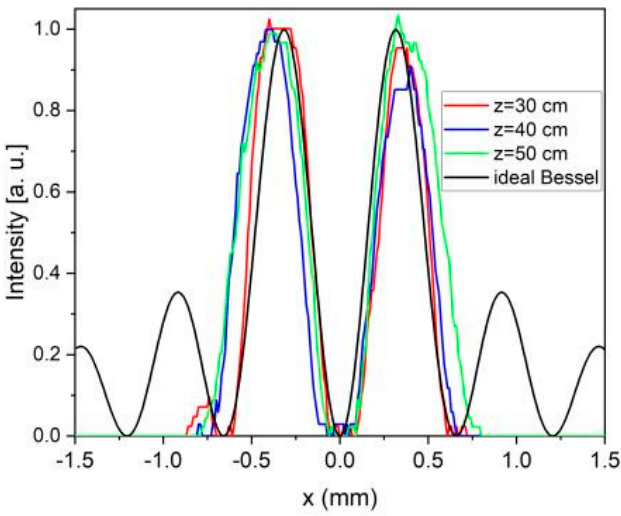
Figure 18. Intensity cross-sections of the first-order Bessel–Gauss beams for z = 30 cm (red line), z = 37 cm (blue line), and z = 42 cm (green line). The black line represents the intensity of an ideal Bessel beam of order zero, |J 1 (k r x)| 2 .